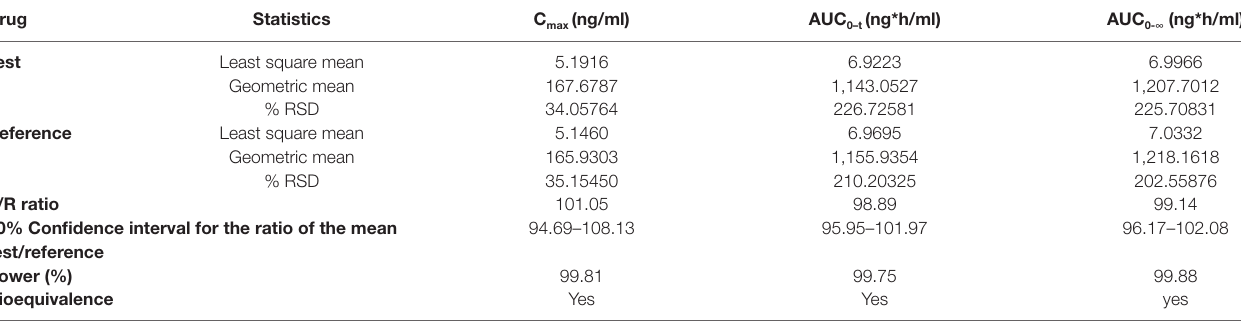
TABLE 8 | ANOVA analysis of primary pharmacokinetic parameters for HCTZ after oral administration of single dose of test and reference tablets in human subjects ( n = 28).